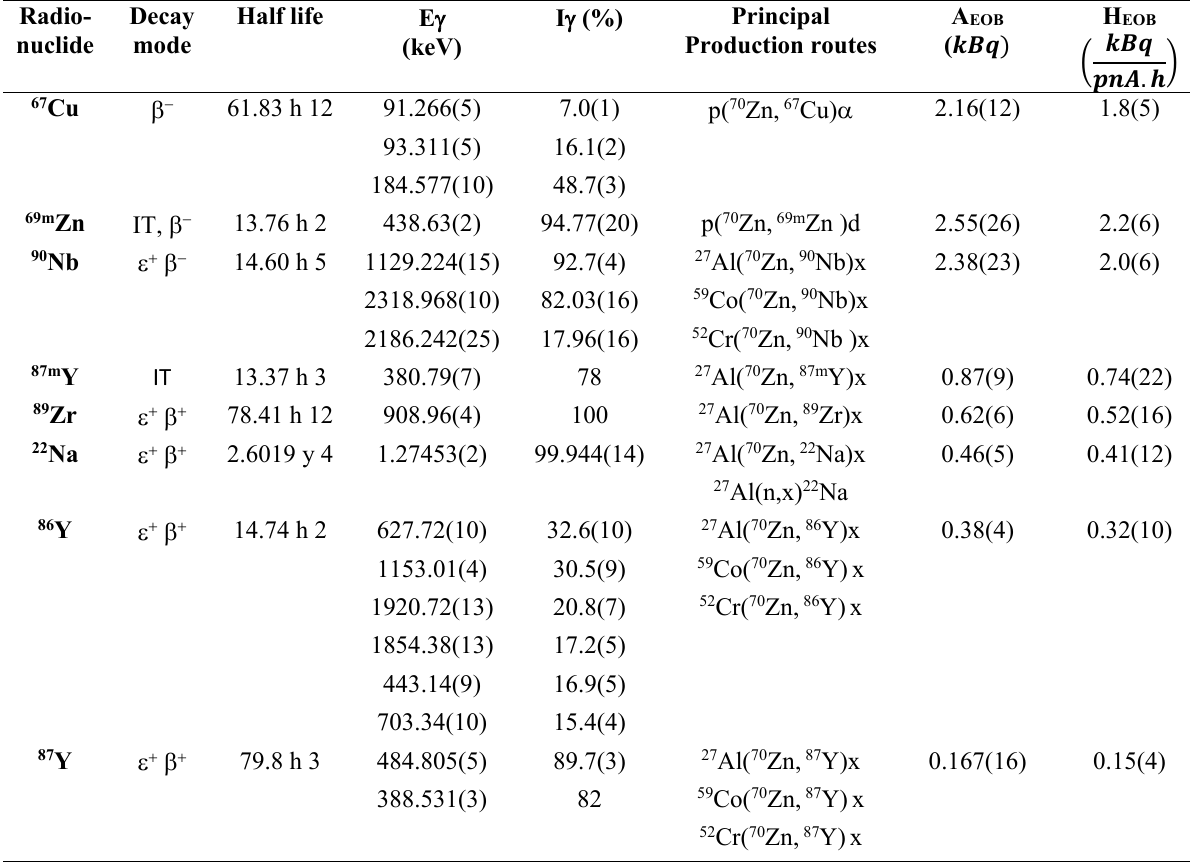
Table 1. Activities obtained in the present work as defined in the text (last two columns) for 67 Cu and the main contaminants, the radioactive decay data of the respective radionuclides, and the contributing reactions. The listed γ rays were used for the activity